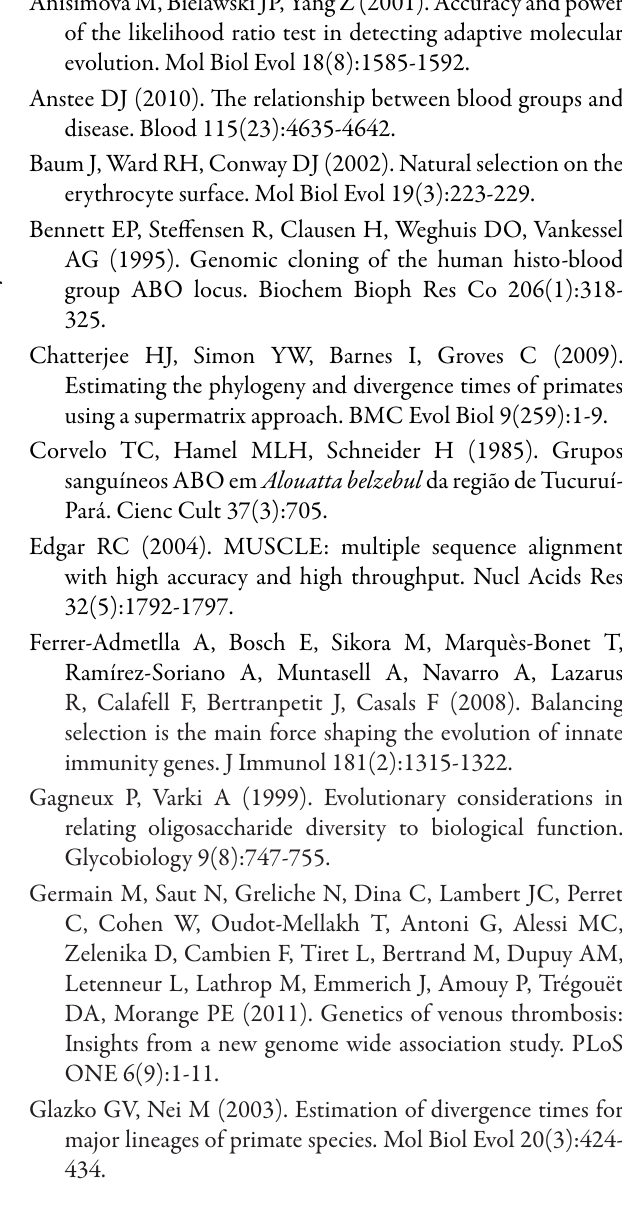
a The likelihood indicates the fit of the data to the different models; b Pi denotes the proportion of sites falling in sites class ω parameters of the beta distribution which underlies M7, M8 and M8a models; d Result of the Likelihood ratio test amont the pair models M1a-M2a, M7-M8 and M8-M8a; e Degree of freedom for χ 2 test; f Codons under positive selection determinate by Bayes empirical Bayes (BEB); h Posterior probabilities for site classes by BEB, values > 95% do is not significantly, but is